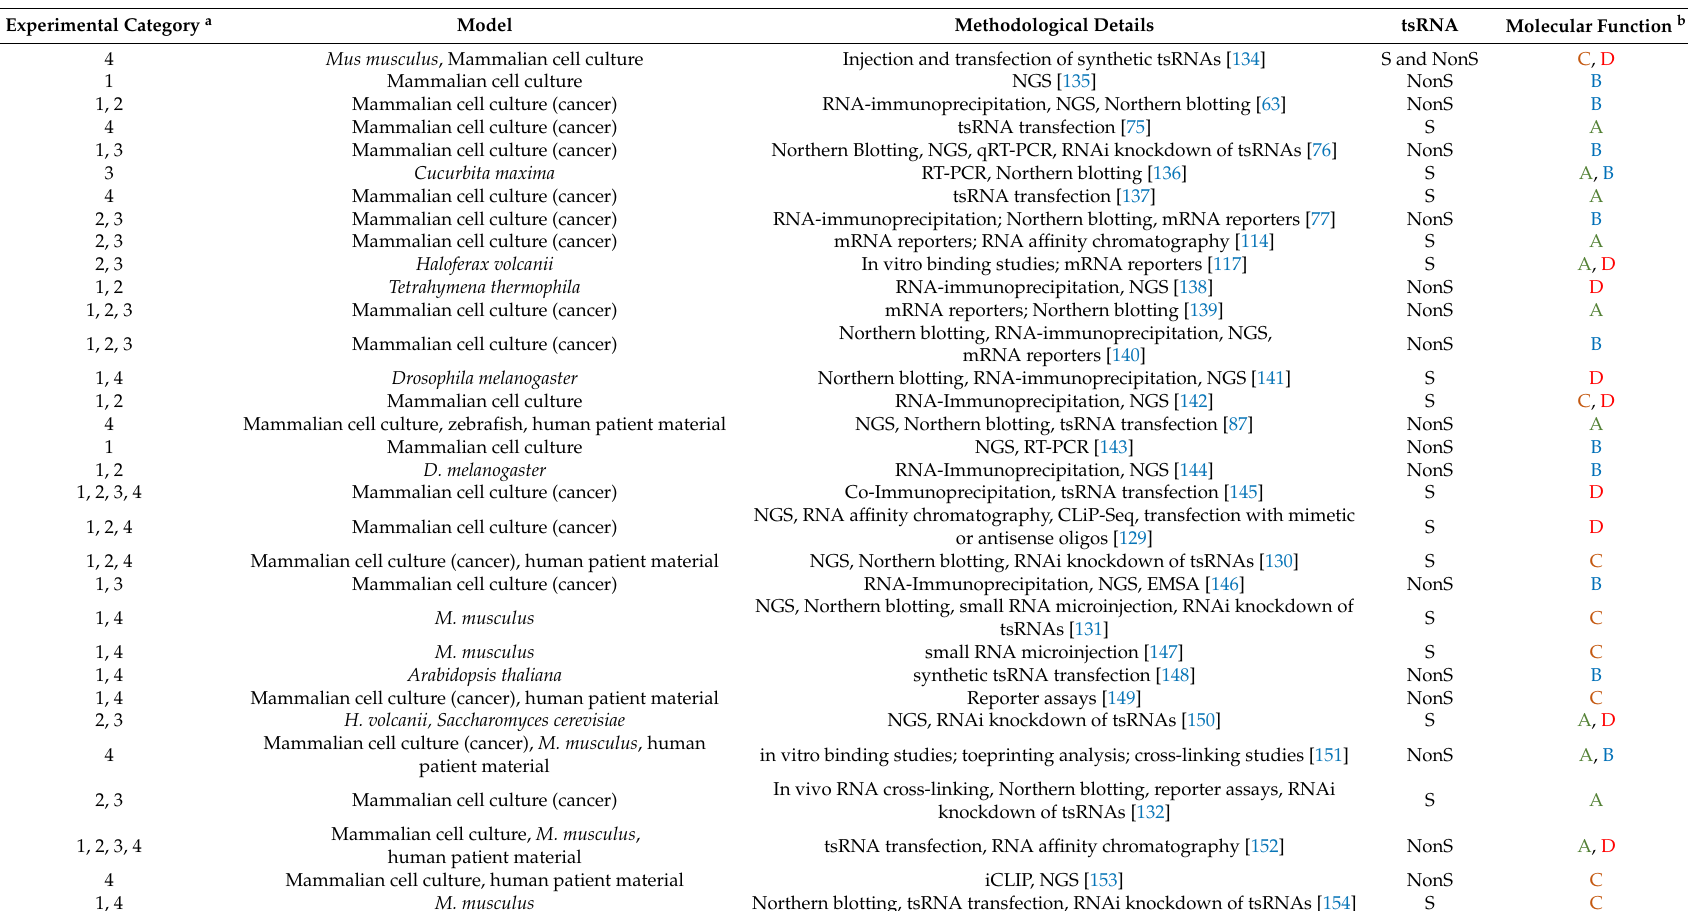
Table 1. Experimental evidence for suggested/reported function of various tsRNAs. Table depicts experimental approaches to identify the molecular function of tsRNAs, models and model organisms, species of tsRNA and suggested/reported molecular function of individual